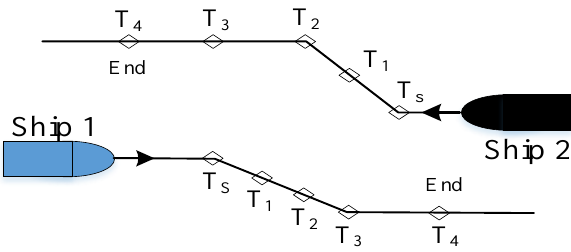
Figure 3. Closest point of approach ( CPA) computation for two planned trajectories.